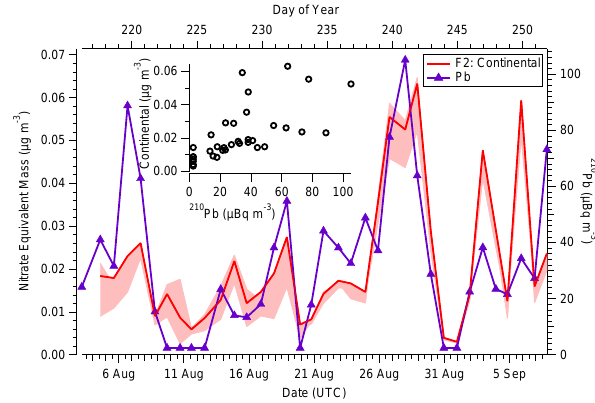
Fig. 9. Time series of the Continental Factor and 210 Pb. Inset shows scatterplot of these two